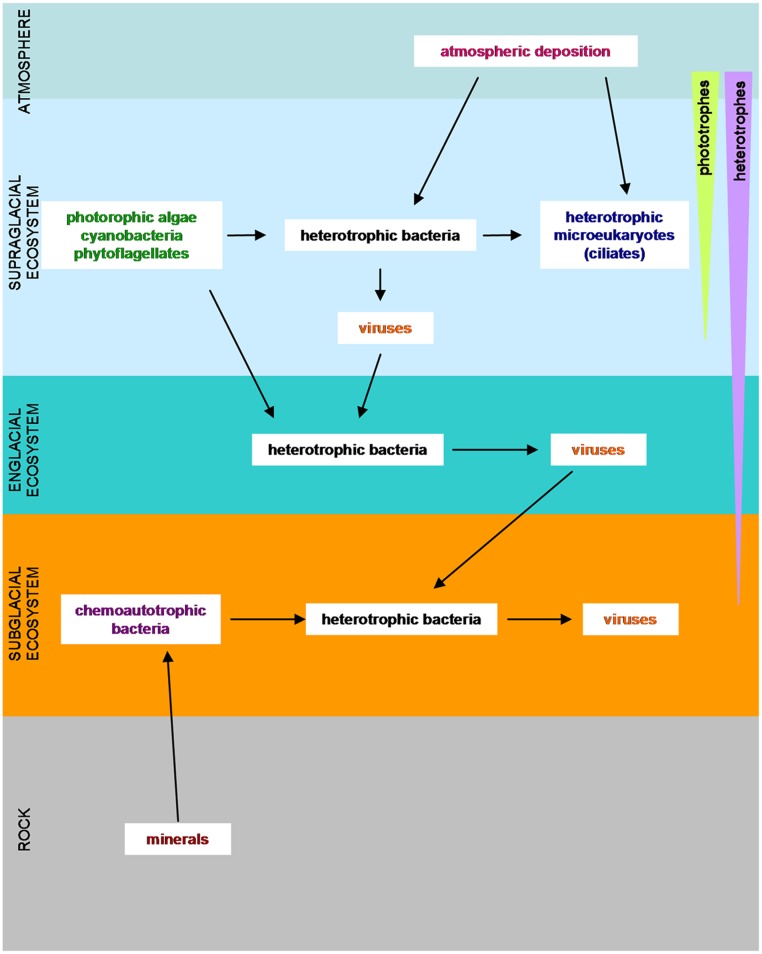
Overview of the microorganisms in glaciers and ice sheets with their food requirements. (Adapted from Hodson et al., 2008; Anesio and Laybourn-Parry, 2012; Garcia-Lopez and Cid, 2017).